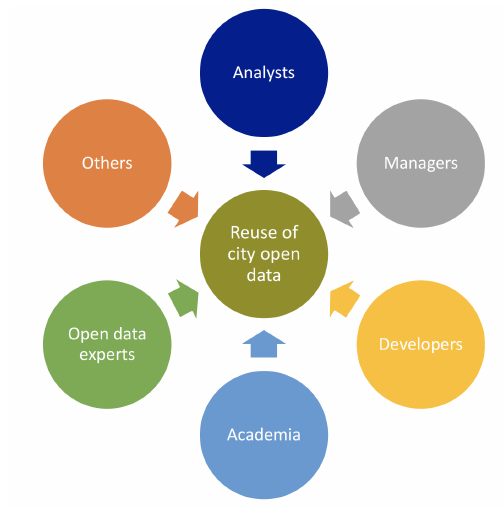
Figure 4. Workshop participant roles. There were 56 from academia, 49 analysts, 20 managers or project leaders, 11 developers, 3 Open data experts and 16 counted as others that include politicians, journalists, entrepreneurs and others roles. In total there were 155 workshop